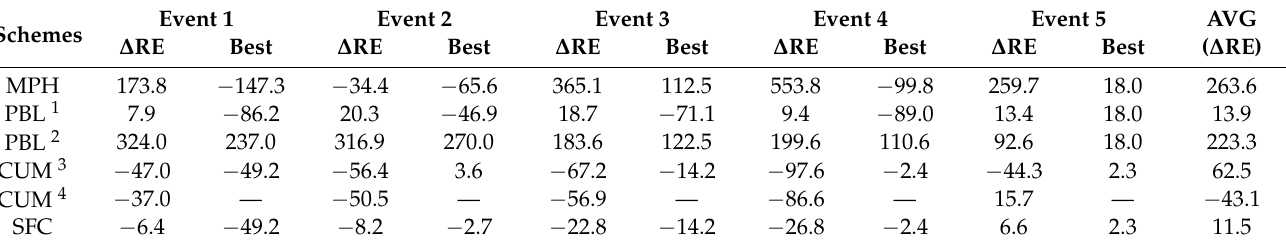
Table 4. RE variation for each simulation set and per event ( ∆ %) and the best RE